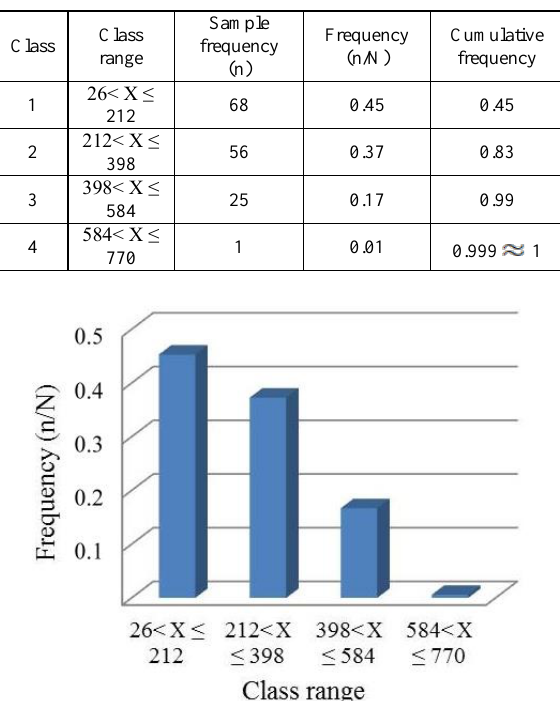
Table 3. Frequency analysis of influent BOD